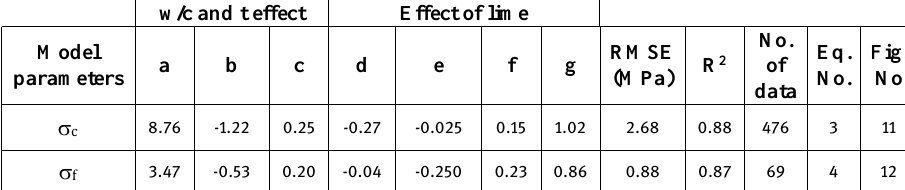
Table 7: Non-linear model (NLM) parameters for the compressive and flexural strengths of cement mortar modified with lime w/c and t effect Effect of